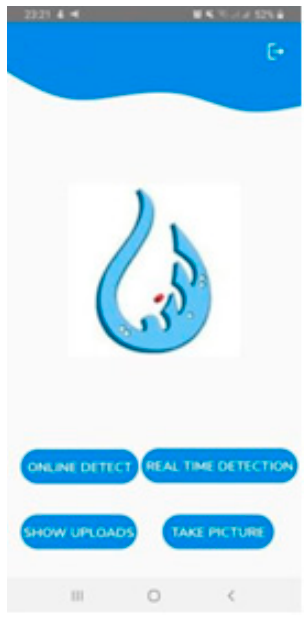
Figure 14. The Home interface.